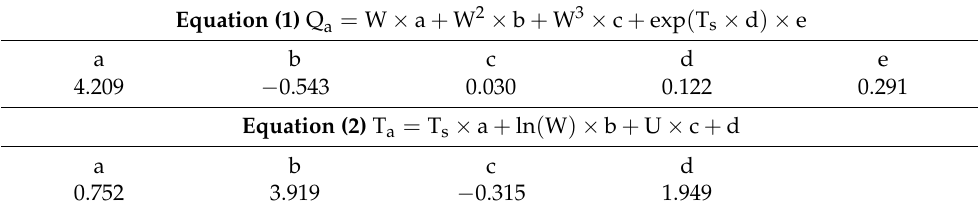
Table 2. Root Mean Square Error (RMSE) and Mean Bias Error (MBE) between satellite- and